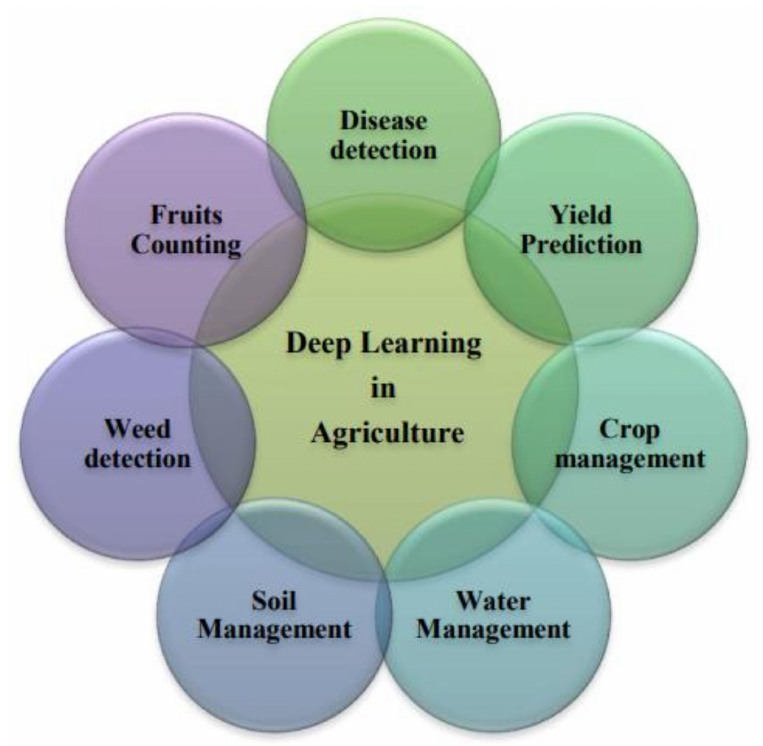
Figure 2. Deep learning applications in agriculture